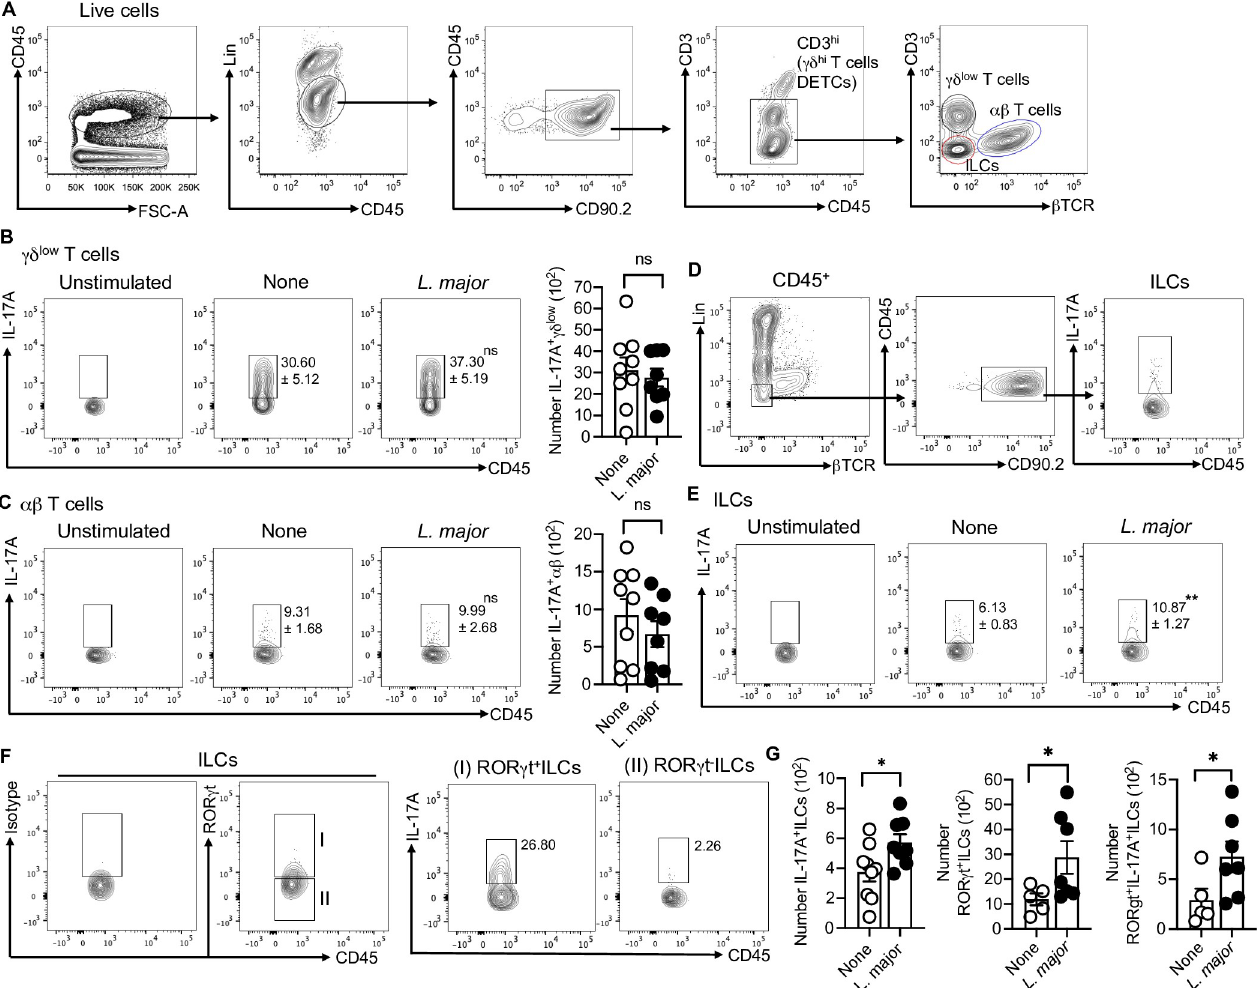
Fig 1. L . major infected skin contains IL-17A-producing ROR γ t + ILCs. (A) Gating strategy to identify skin T cells and ILCs. (B) Percent and number of IL- 17 Α + γδ low T cells in the skin of uninfected (None) and L . major infected mice at week one. (C) Percent and number of IL-17 Α + αβ T cells in the skin of uninfected (None) and L . major infected mice at week one. (D) Together with A, gating strategy to identify IL-17A + ILCs in skin. (E) Percent of IL-17 Α + ILCs in the skin of uninfected (None) and L . major infected mice at week one. (F) Gating strategy to identify ROR γ t + IL-17A + ILCs in skin at week one. (G) Number of IL-17 Α + ILCs, ROR γ t + ILCs and ROR γ t + IL-17A + ILCs in skin of uninfected (None) and L . major infected mice at week one. For intracellular staining cells were stimulated with PMA/Ion for 4 hours. Unstimulated cells were used as control to define the gates (B,C,E). Data are from two experiments with a total of five to nine mice in each group (B,C,E,G). Number within the flow plot show percent of IL-17A + cells with SEM (B,C,E). Error bars shows SEM. Two-tailed unpaired Student’s t-test with Welch’s correction. � p < 0.05, �� p < 0.01, ��� p < 0.001.